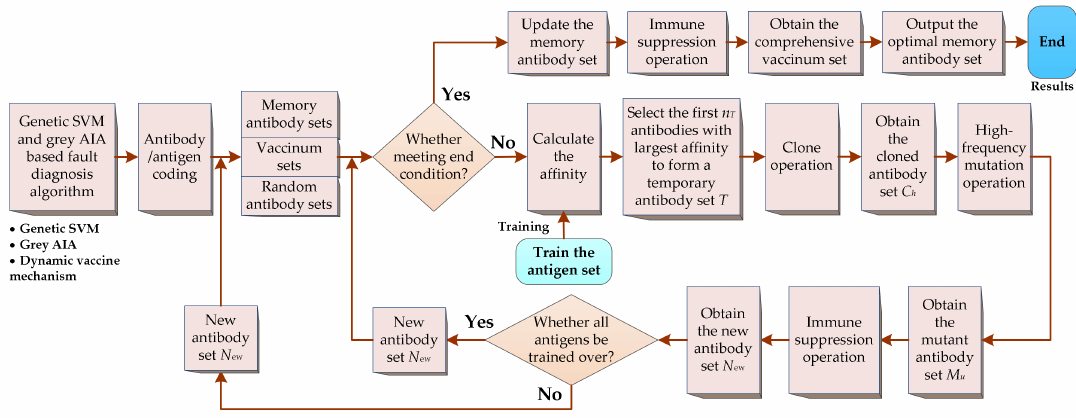
Figure 11. The grey AIA based dynamic vaccine mechanism flow chart presented in